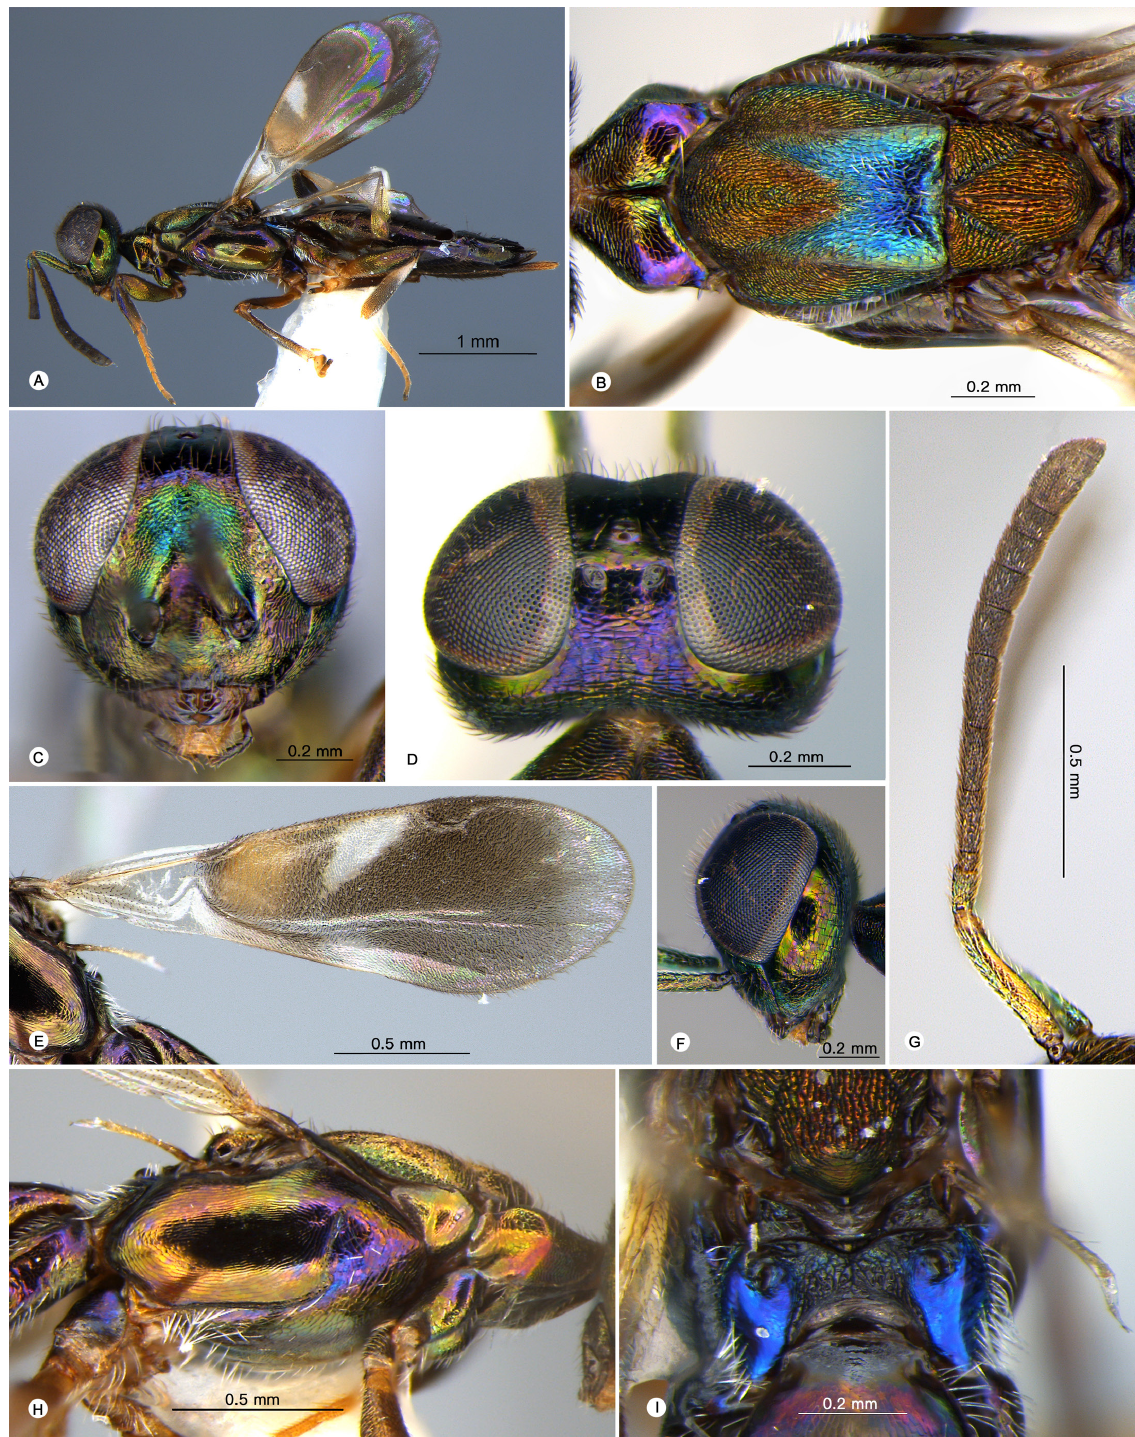
Fig. 1. Zaischnopsis covid Jiang & Peng sp. nov. A . Body, lateral view. B . Mesosoma, dorsal view. C . Head, front view. D . Head, dorsal view. E . Fore wing. F . Head, lateral view. G . Antenna. H . Mesosoma, lateral view. I .